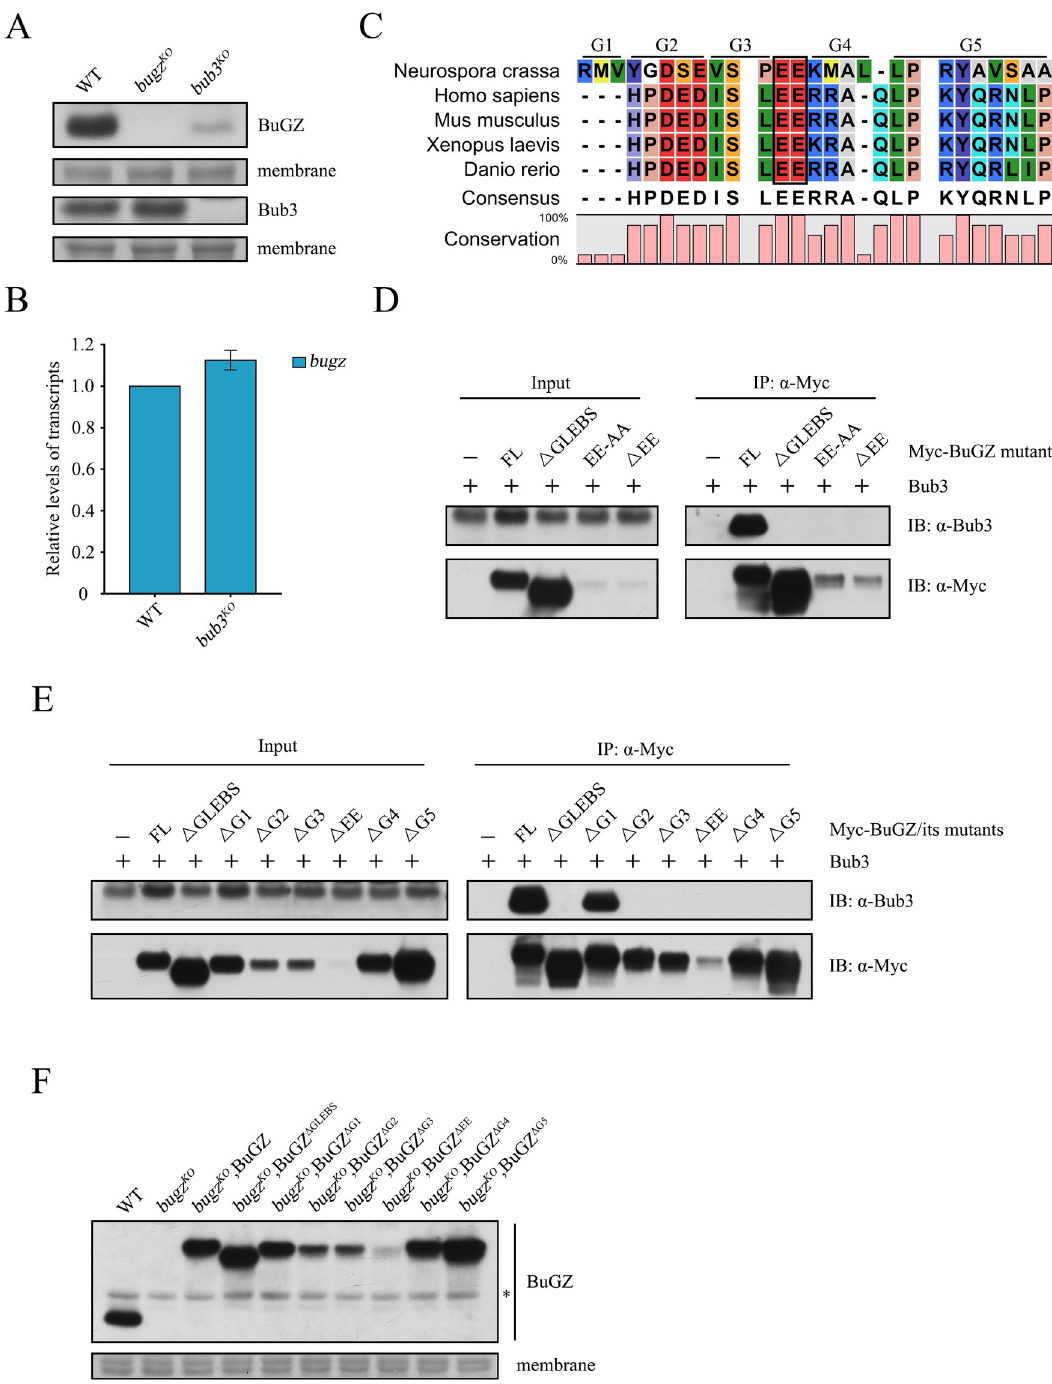
Fig 3. BuGZ stability does not depend on the Bub3-BuGZ interaction. (A) Western blot for BuGZ and Bub3 proteins in WT, bugz KO , and bub3 KO strains. The membranes stained by Coomassie blue served as the loading control. (B) RT-qPCR quantification of bugz mRNA in bub3 KO strain relative to WT. (C) Amino acid sequence alignment of the conserved GLEBS domain of BuGZ from Neurospora crassa , Homo sapiens , Mus musculus , Xenopus laevis , and Danio rerio . The conserved EE residues are indicated by a black box, and G1~G5 segments are marked. (D) Co-immunoprecipitation assays analyzed by western blot to evaluate the interaction between Myc-BuGZ, Myc-BuGZ Δ GLEBS , Myc-BuGZ EE-AA , or Myc-BuGZ Δ EE and endogenous Bub3. (E) Co-immunoprecipitation assays analyzed by western blot to evaluate the interaction between Myc-BuGZ, Myc-BuGZ Δ GLEBS , Myc-BuGZ Δ G1~ Δ G5 , or Myc- BuGZ Δ EE and endogenous Bub3. (F) Western blot analyses of the levels of BuGZ protein in WT, bugz KO , bugz KO ,BuGZ, bugz KO